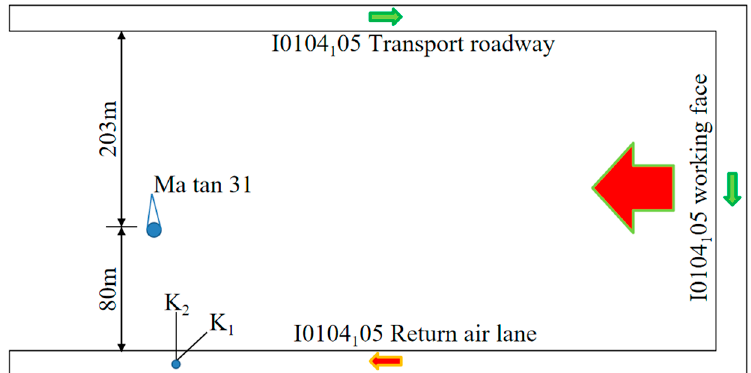
Figure 2. Schematic diagram of detection drilling layout.